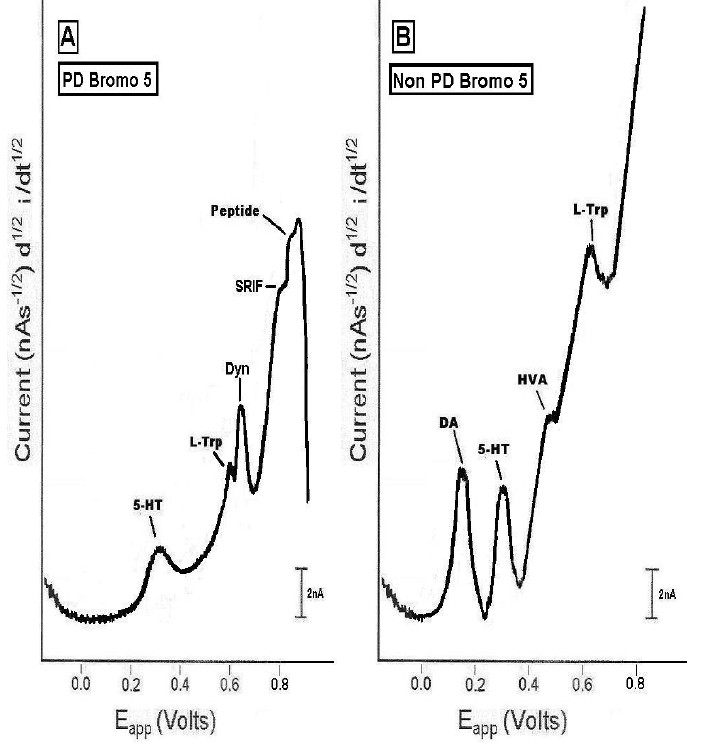
Figure 3. Representative NMI neurochemical signature profiles in dorsal striatum of the (left) PD and (right) the non-PD animal, after administration of the dopamine agonist, bromocriptine (5 mg/kg, ip; low dose) in vivo , on line and in real time. Neurochemical profiles in PD versus non-PD are drawn from original